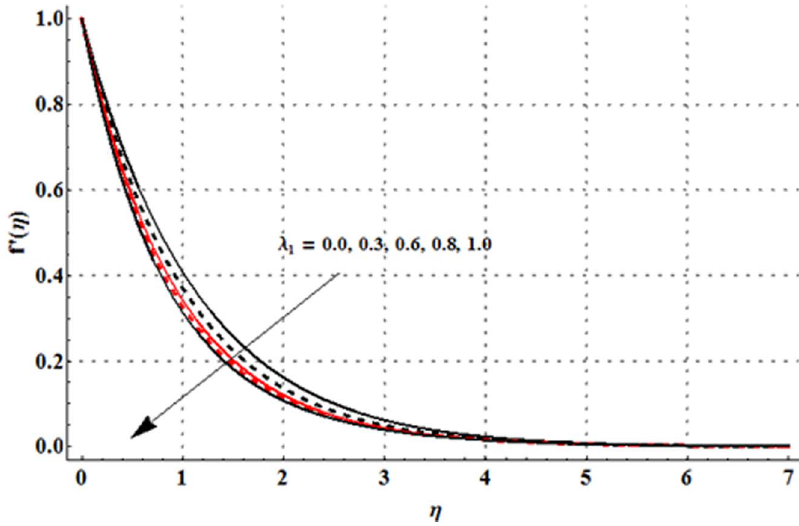
Figure 5. Influence of l 1 on the velocity profile f ’ ( g ) when M ~ 0 : 6, b ~ 0 : 4 ~ Rd , l ~ 0 : 3 ~ N , Pr ~ 1 : 2, S ~ 0 : 2 ~ S (cid:2) and Sc ~ 1 : 0 :